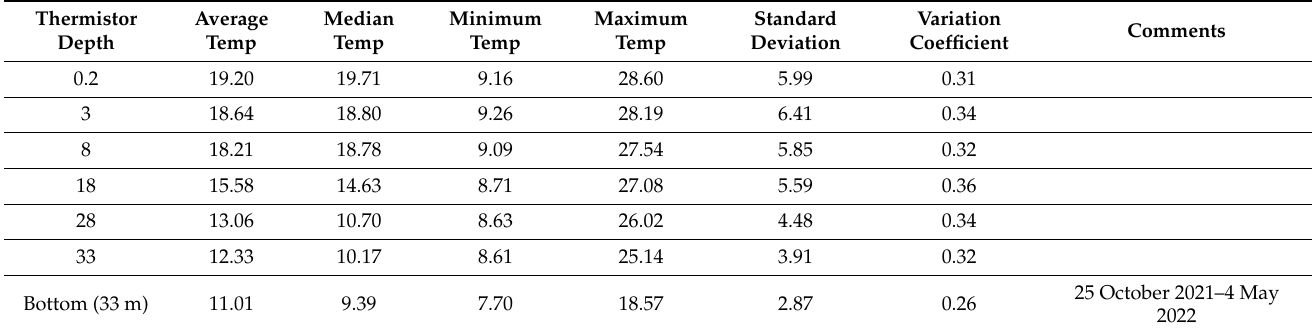
Table 3. Statistical parameters of water temperature at different depths during the third measurement period of the thermochain (15 March 2021–25 October 2021—for each horizon, except bottom) (25 October 2021–4 May 2022—for the